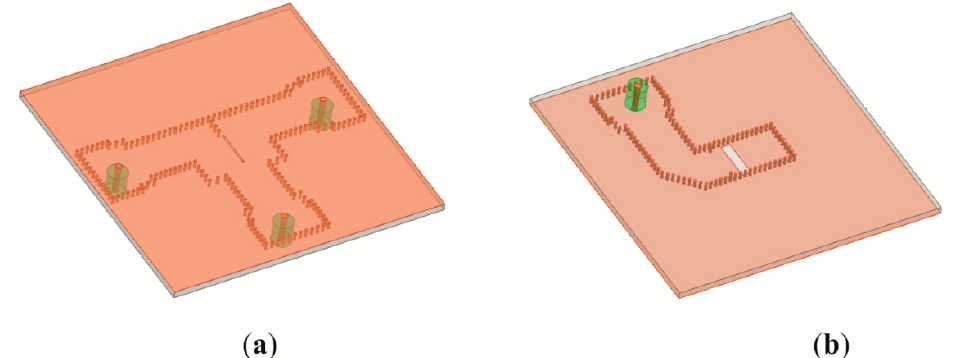
Figure 10. Layers of the Magic Tee: ( a ) First layer with the H-plane T-junction; ( b ) Second layer with the E-plane junction.